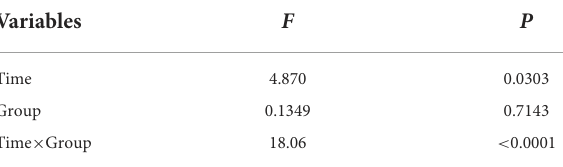
TABLE 3 Repeated measures ANCOVA of TRD and HC at baseline and post taVNS stimulation period. Variables F P